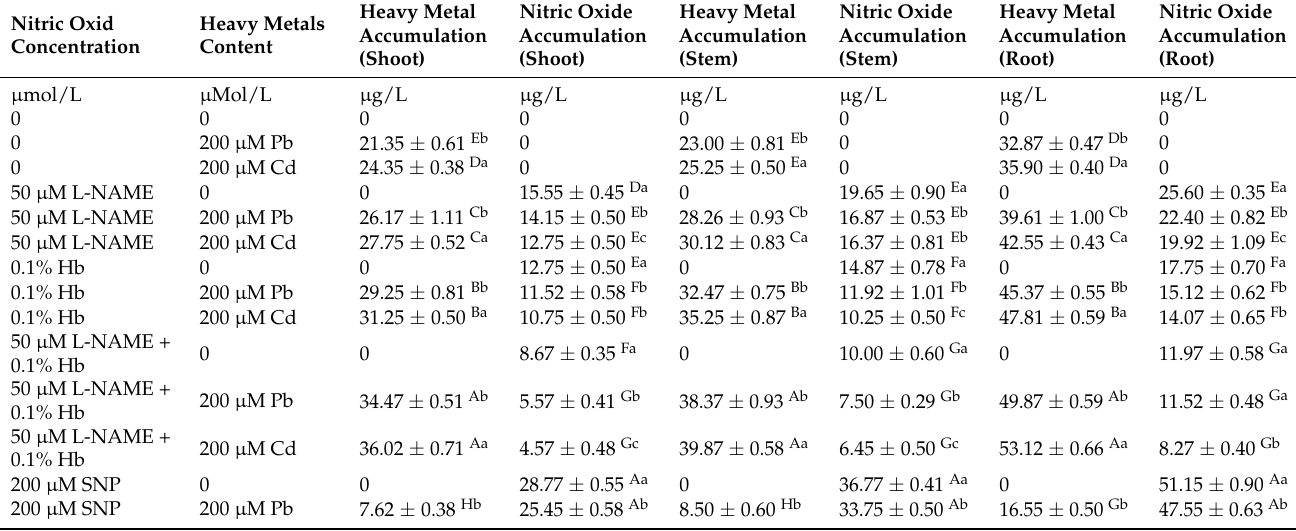
Table 2. The accumulation levels of different concentrations of nitric oxide and heavy metal (Pb, Cd) contents in bamboo shoots, stems, and